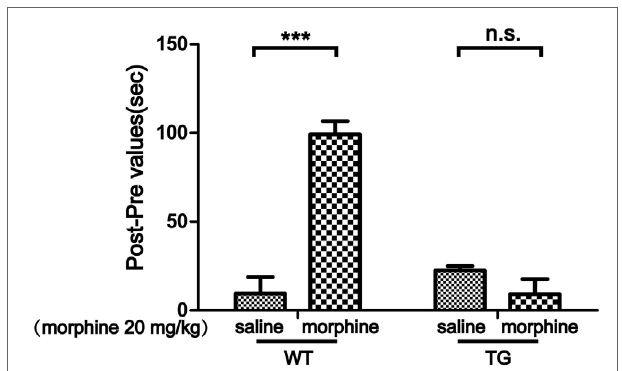
FigUre 2 | Effects of thioredoxin-1 (Trx-1) overexpression on morphine- induced conditioned place preference (CPP) in mice. The morphine-induced CPP was blocked in Trx-1 overexpressing transgenic (TG) mice. Mice were treated with morphine (20 mg/kg, intraperitoneally). Each bar represents